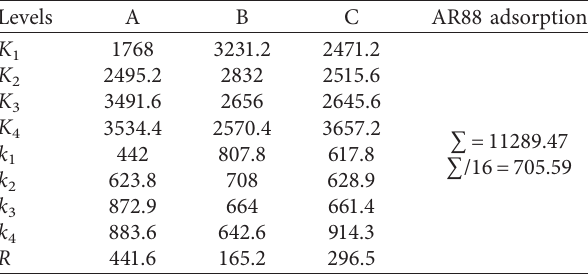
Table 3: Range analysis of the orthogonal experiment.